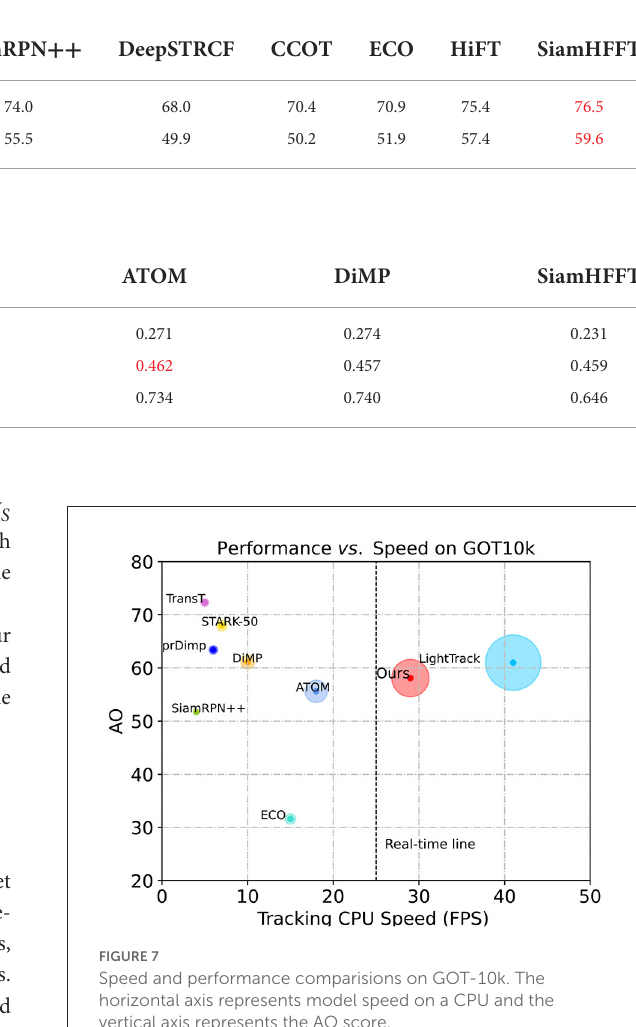
TABLE 2 Overall evaluation on UAV123@10fps.